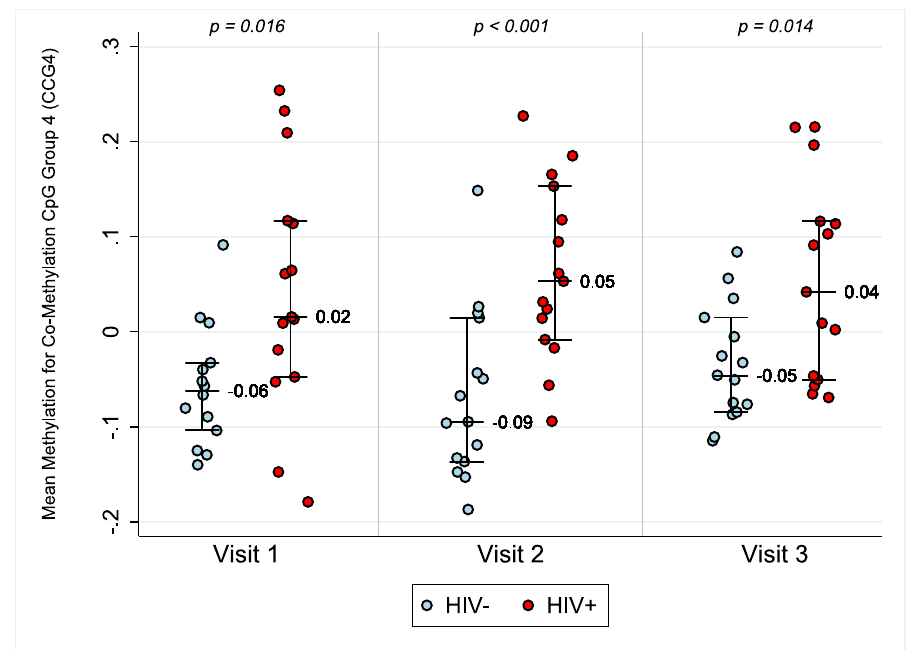
Figure 3. Co-methylated CpG groups are associated with HIV status before and after the initiation of ART. This figure shows boxplots for co-methylated CpG group 4 identified from Weighted Gene Correlation Network Analysis (WGCNA). P values shown were calculated using the Wilcoxon rank sum tests between the two serostatus groups at the 3 time